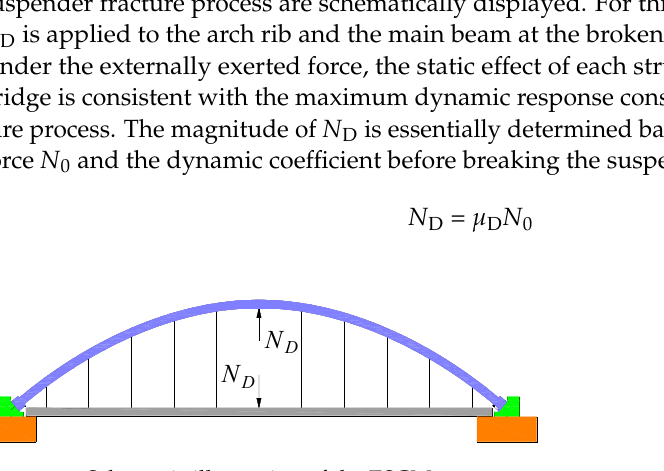
Figure 17. Schematic illustration of the ESCM.